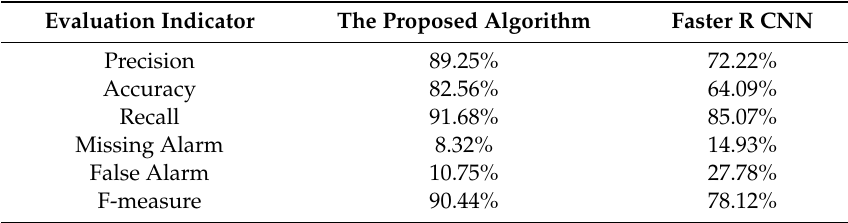
Table 2. Some evaluation